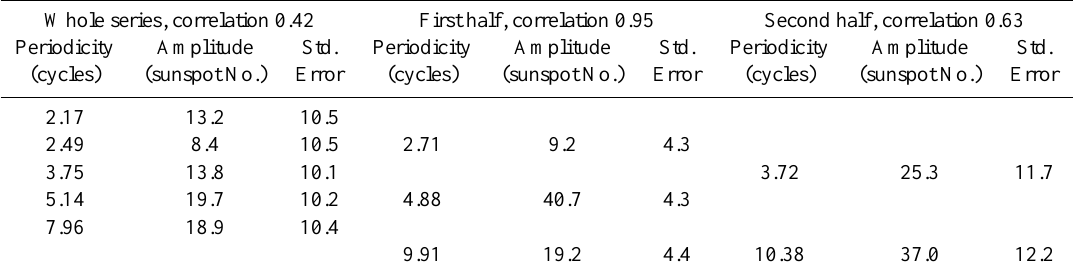
Table 5. Periodicities (in solar cycles) and their amplitudes (units of sunspot number) with standard errors, for the whole series of Rz (max) (cycles − 4 to 22), and for the first half (cycles − 4 to 9) and second half (cycles 10–22). Whole series, correlation 0.42 First half, correlation 0.95 Second half, correlation 0.63 Periodicity Amplitude Std. Periodicity Amplitude Std. Periodicity Amplitude Std. (cycles) (sunspot No.) Error (cycles) (sunspot No.) Error (cycles) (sunspot No.)